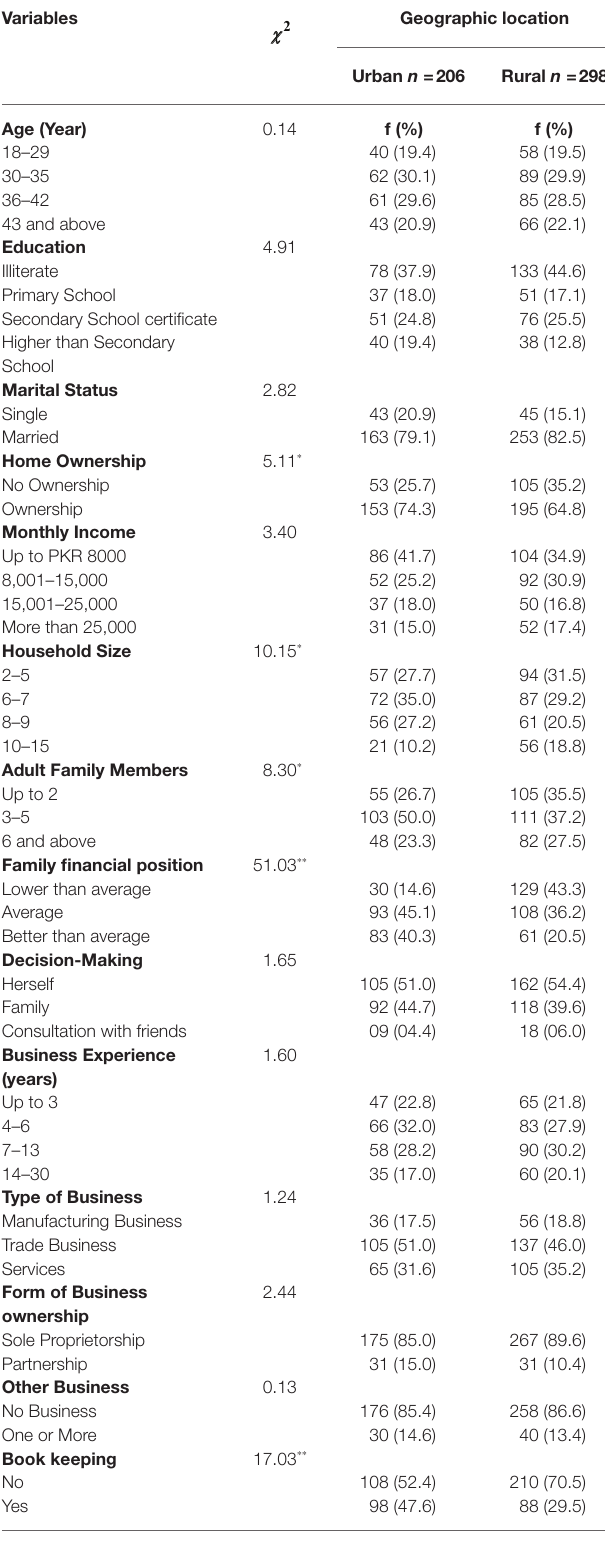
TABLE 2 | Bivariate association of geographic location and independent variables.